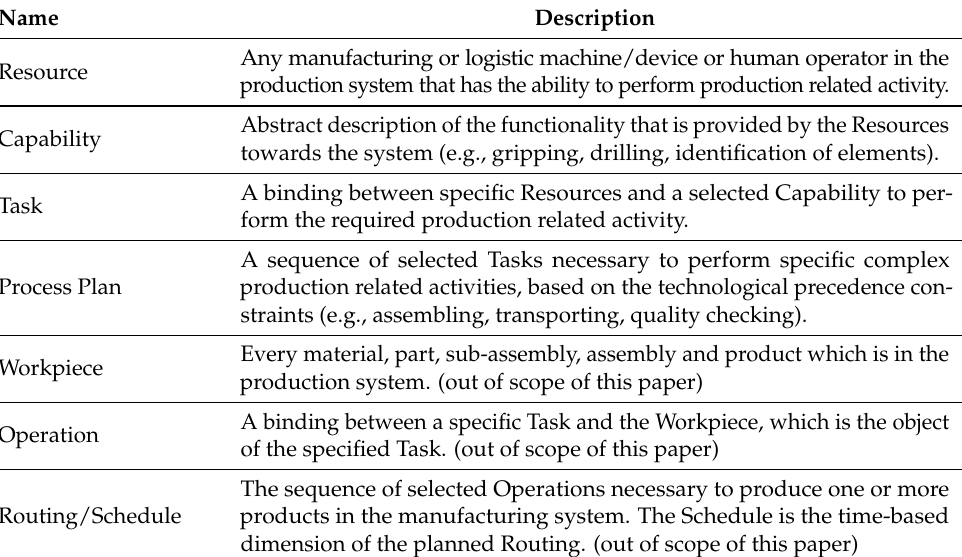
Table 3. List of manufacturing concepts